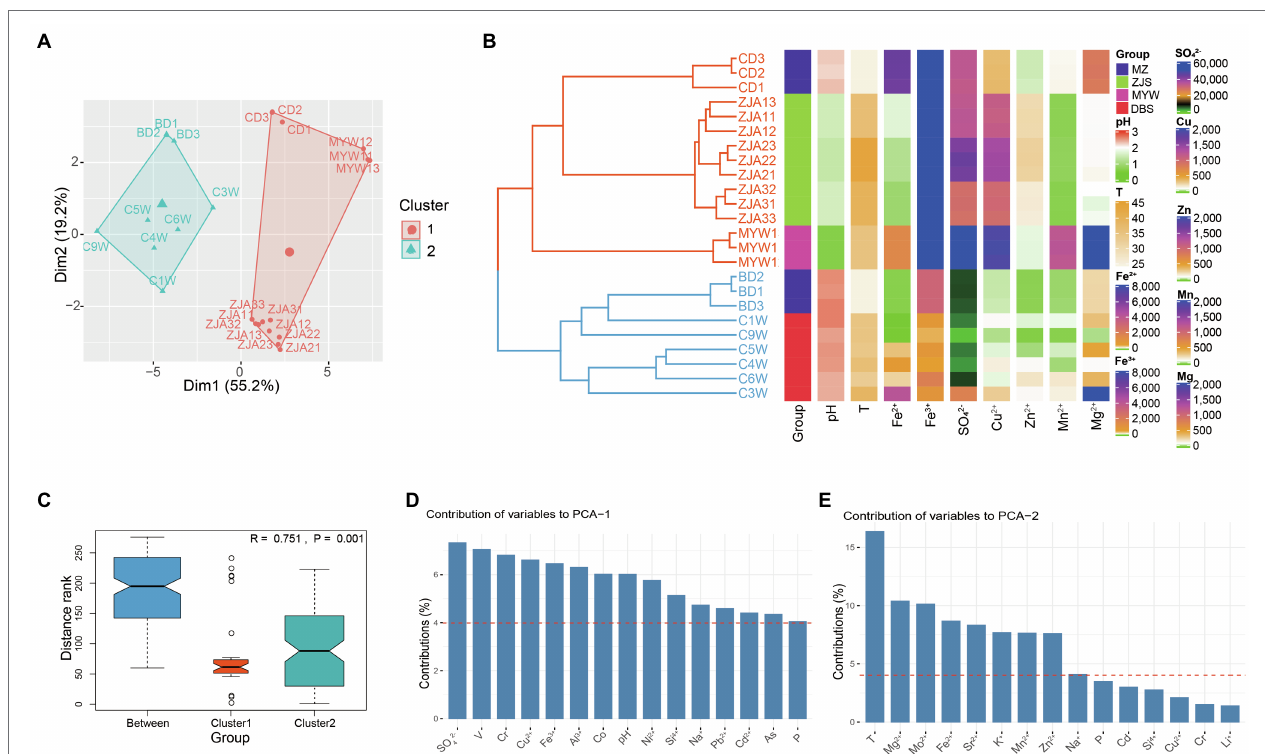
FIGURE 1 | Differences in physicochemical properties of acid mine drainage (AMD) from different mining areas. (A) Principal components analysis of AMD samples. (B) Hierarchical clustering of samples based on all environmental factors ( k = 2, Euclidean distance and average clustering method was used) and heatmaps for important environmental factors. T represents temperature; units for ion concentrations are mg L − 1 . (C) Anosim analysis of differences between groups and within groups. Here, group means cluster generated by hierarchical clustering. Contribution of environmental variables to PCA1 (D) and PCA2 (E) of PCA